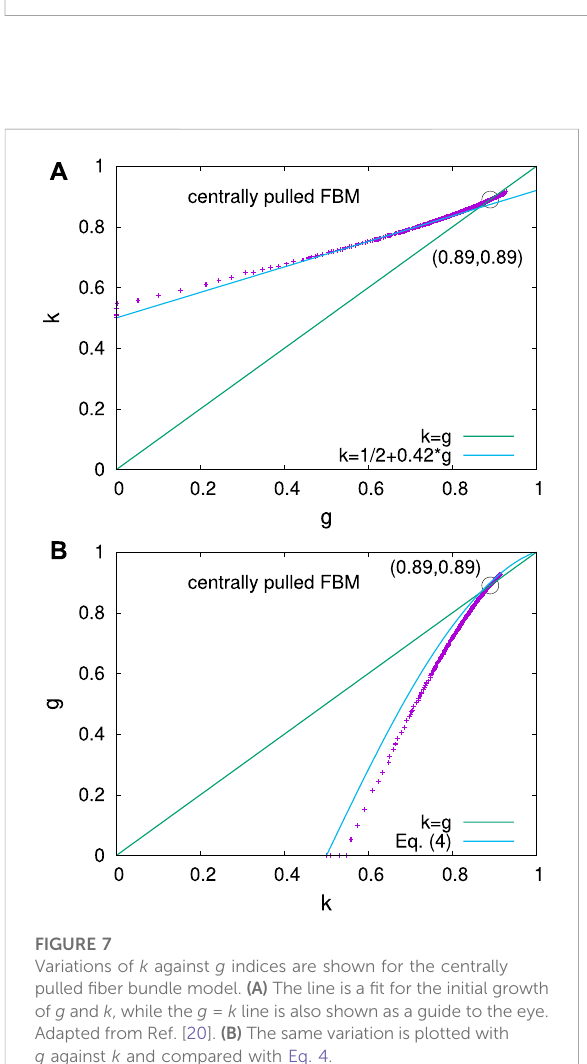
FIGURE 6 (A) BTW sandpile model: The values of the Kolkata k c ( L ) and the Gini g c ( L ) indices (at the point when they cross) have been plotted as a function of the system sizes L = 128, 256, 512, and 1024. The crossing point ( g = k = g c = k c ) values of the indices decrease with the system size. (Inset) The values of k c = g c as a function of L have been extrapolated with respect to L − 1/ ] , where the value of ] for the BTW model has been tuned for the best possiblelinear fi tofthedata,anditgives1/ ] =1.776,giving,inturn, k c = g c =0.863inthelimitof L → ∞ . (B) Mannasandpilemodel:Thevaluesof the Kolkata index k c ( L ) and the Gini index g c ( L ) have been plotted against the system sizes L = 128, 256, 512, and 1024. The values of the indices decrease with the system size. (Inset) The values of k c = g c as a function of L have been extrapolated with respect to L − 1/ ] , and the value of the exponent ] hasbeentunedforthebestpossible fi tofthedata.Theplotshowsthatthebest fi tcorrespondsto1/ ] =2.162fortheMannamodel,giving, in turn, k c = g c = 0.8554 in the limit of L → ∞ . Adapted from Ref. [20].